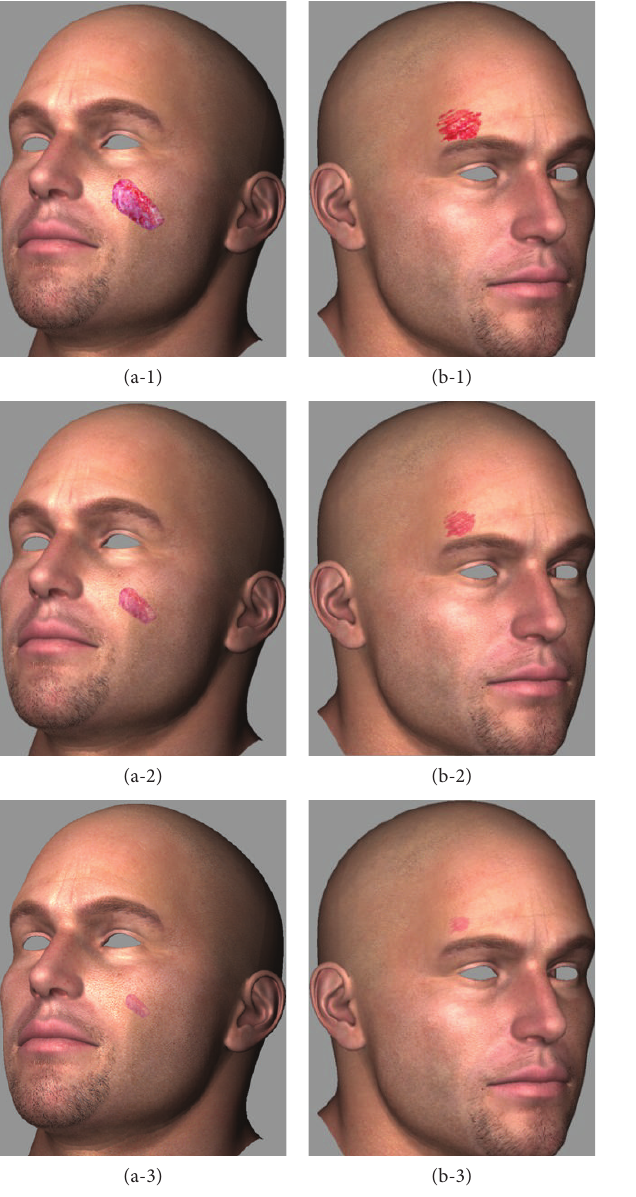
Figure 9: Results of rendering of the